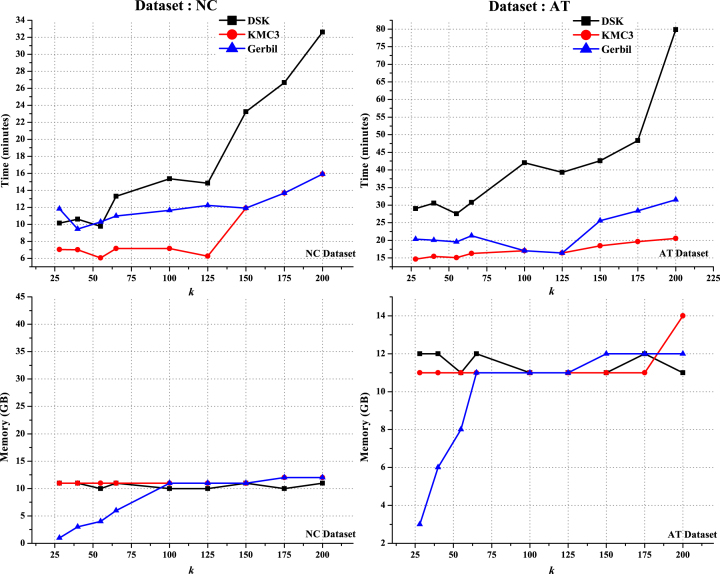
Analysis of time and memory utilization of k-mer counting algorithms for the NC and AT datasets for different values of k (28, 40, 55, 65, 100, 125, 150, 175, and 200).